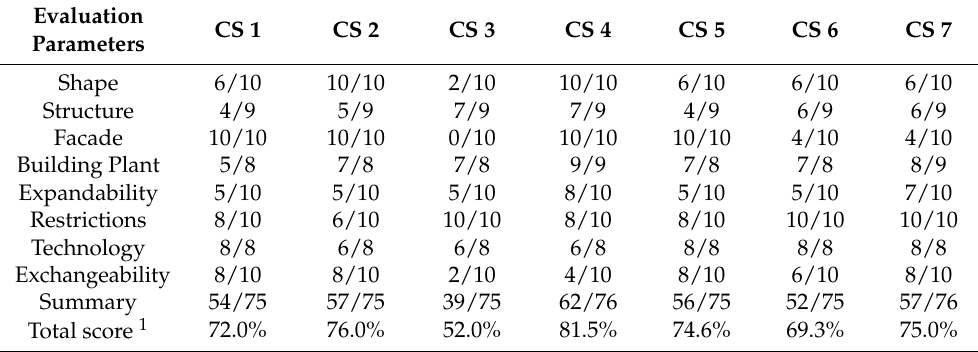
Table 7. Evaluation Parameters Scores of Selected Case Studies.